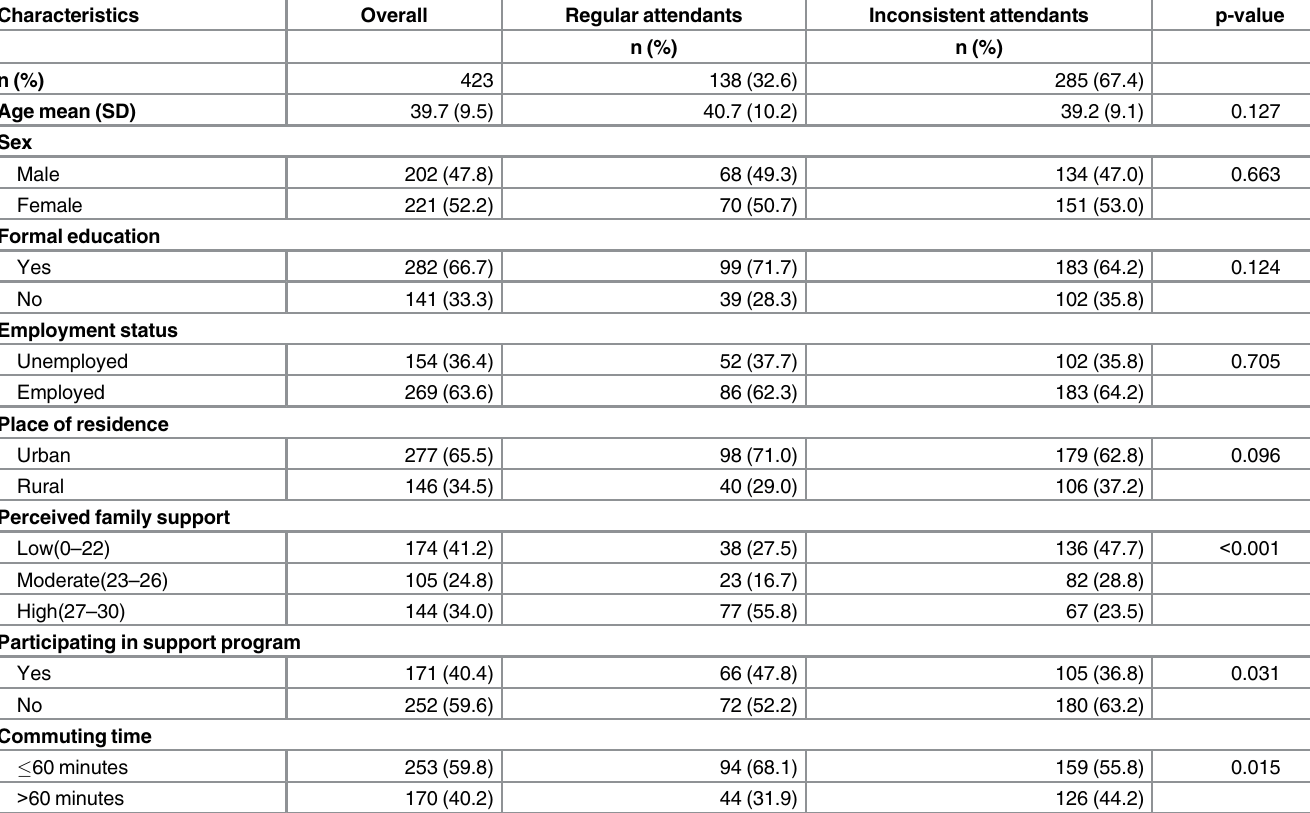
Table 1. General characteristics of the